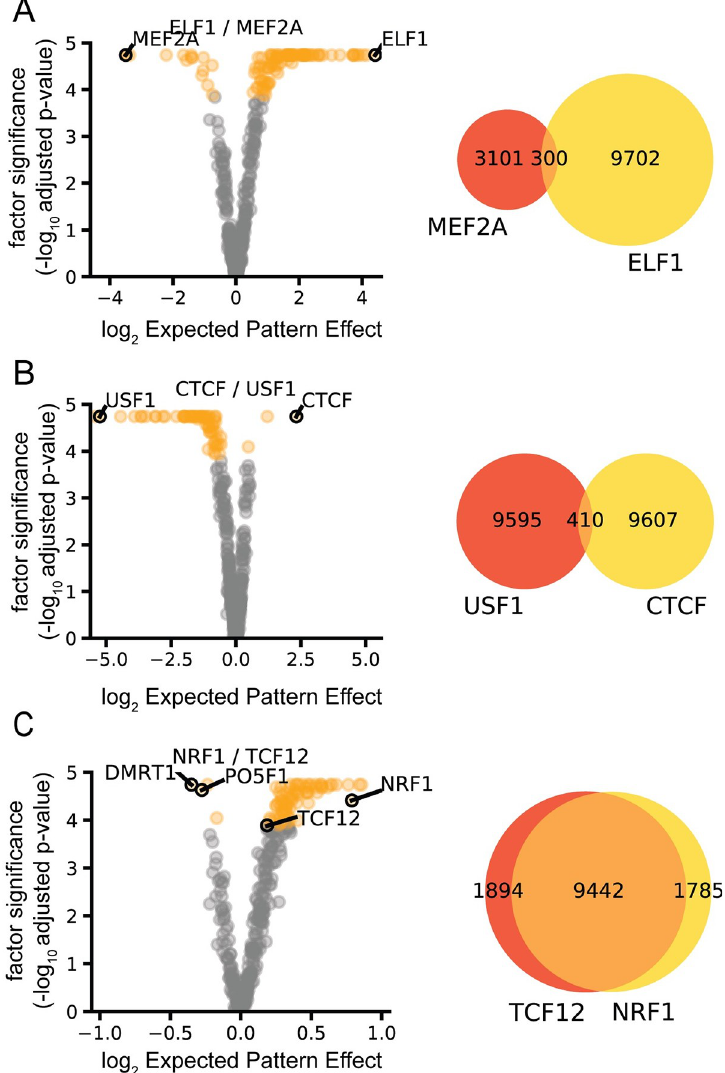
Fig 2. Differential Expected Pattern Effect identifies condition-specific transcription factor activity from DeepAccess models. DeepAccess trained on mouse ChIP-seq data identifies correct motifs driving differential transcription factor activity for (A) ELF1 and MEF2A, (B) CTCF and USF1, (C) NRF1 and TCF12. In the scatter plot each point represents one of 356 HOCOMOCOv11 transcription factor motifs. Orange points are significant transcription factor motifs ( p < 0.05) under Bonferroni multiple hypothesis correction. Venn diagrams show number and overlap of ChIP-seq binding events used as training and testing data for DeepAccess.